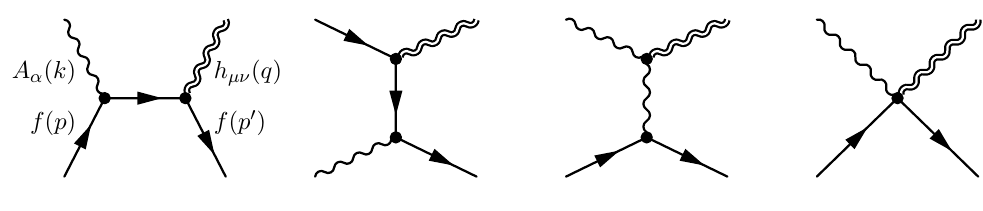
Figure 2 . Gravi-Compton